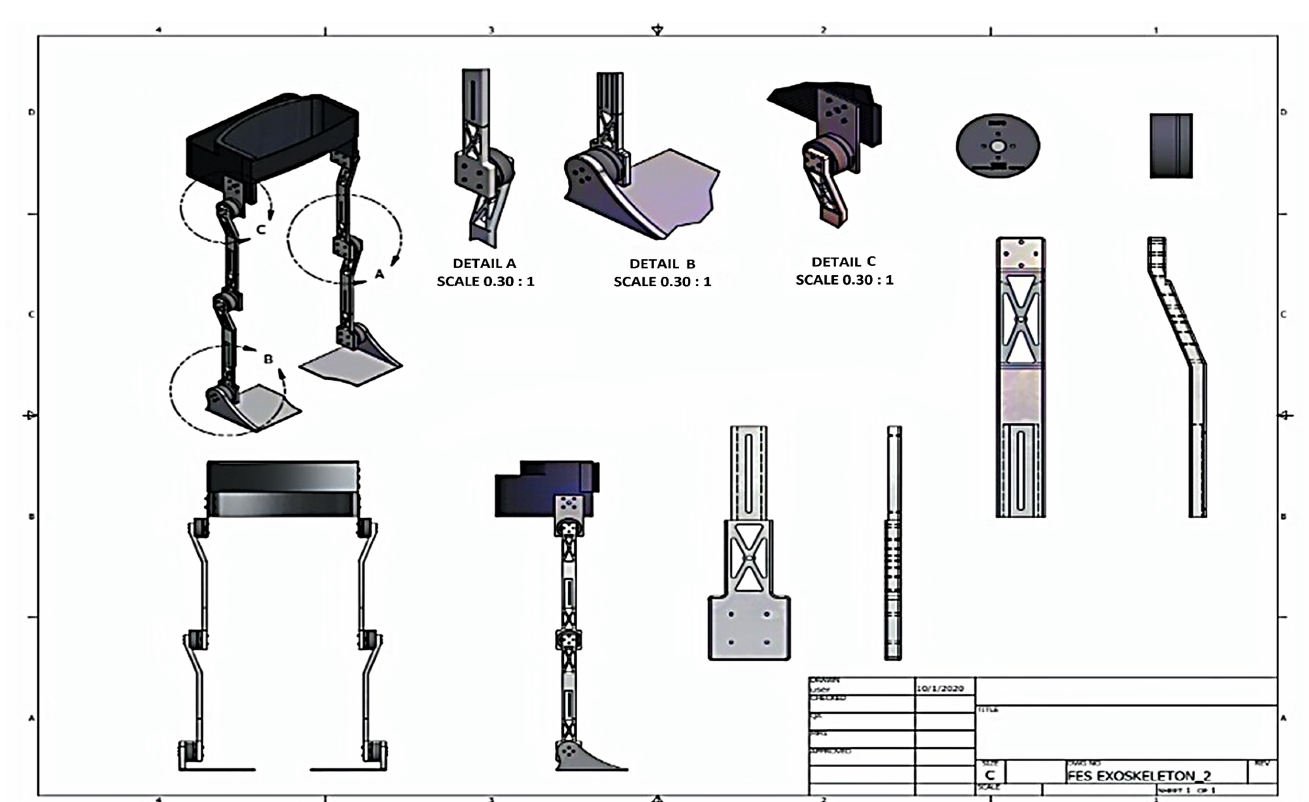
Figure 2. Robotic exoskeleton design plan of the Hybrid Exoskeleton FesRobex (Autocad